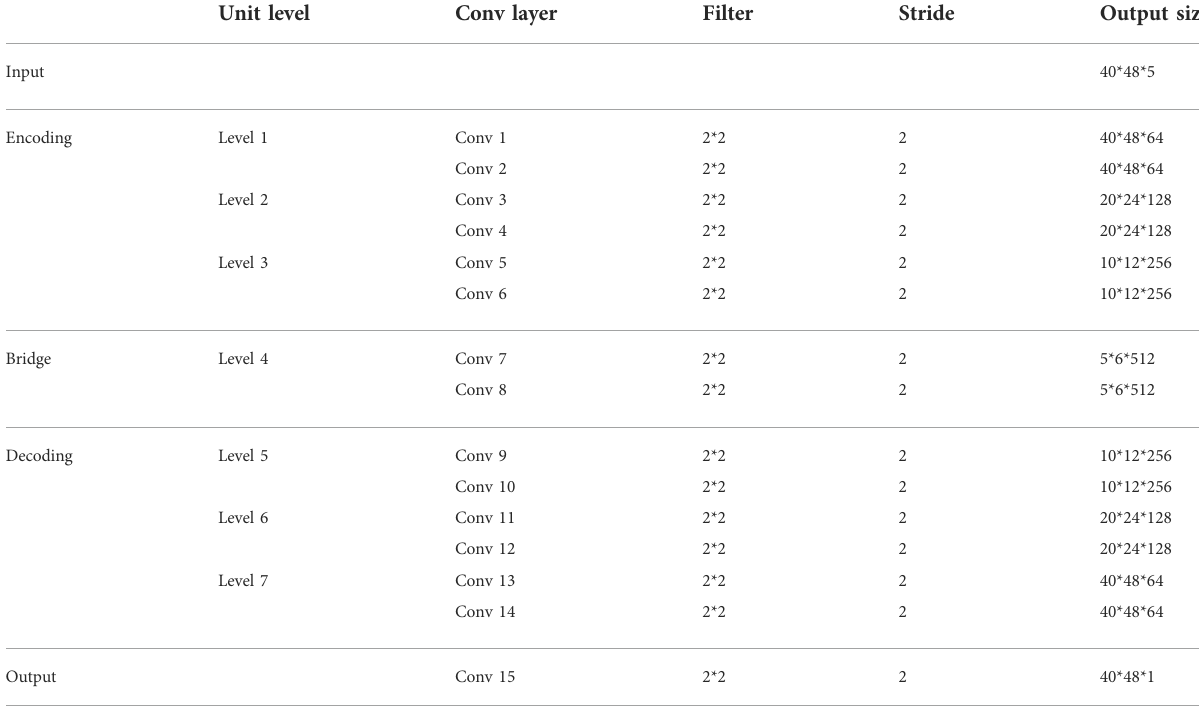
TABLE 1 Numerical weather prediction products (NWPP) model